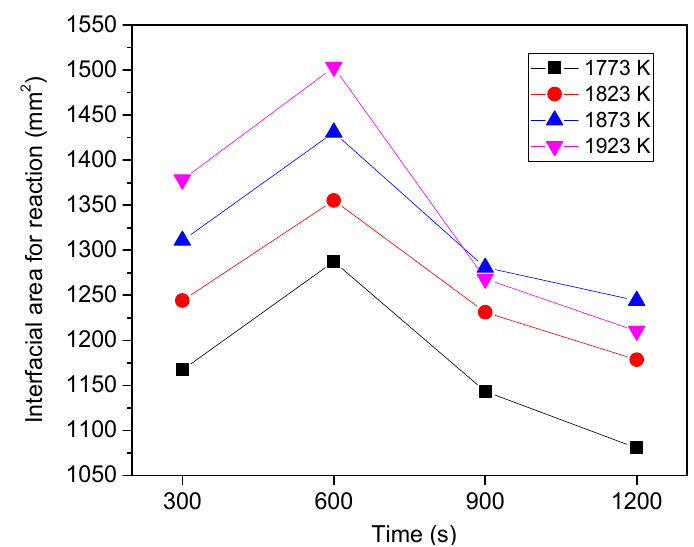
Figure 15. E ff ect of heating temperature on the interfacial area between the molten slag and the